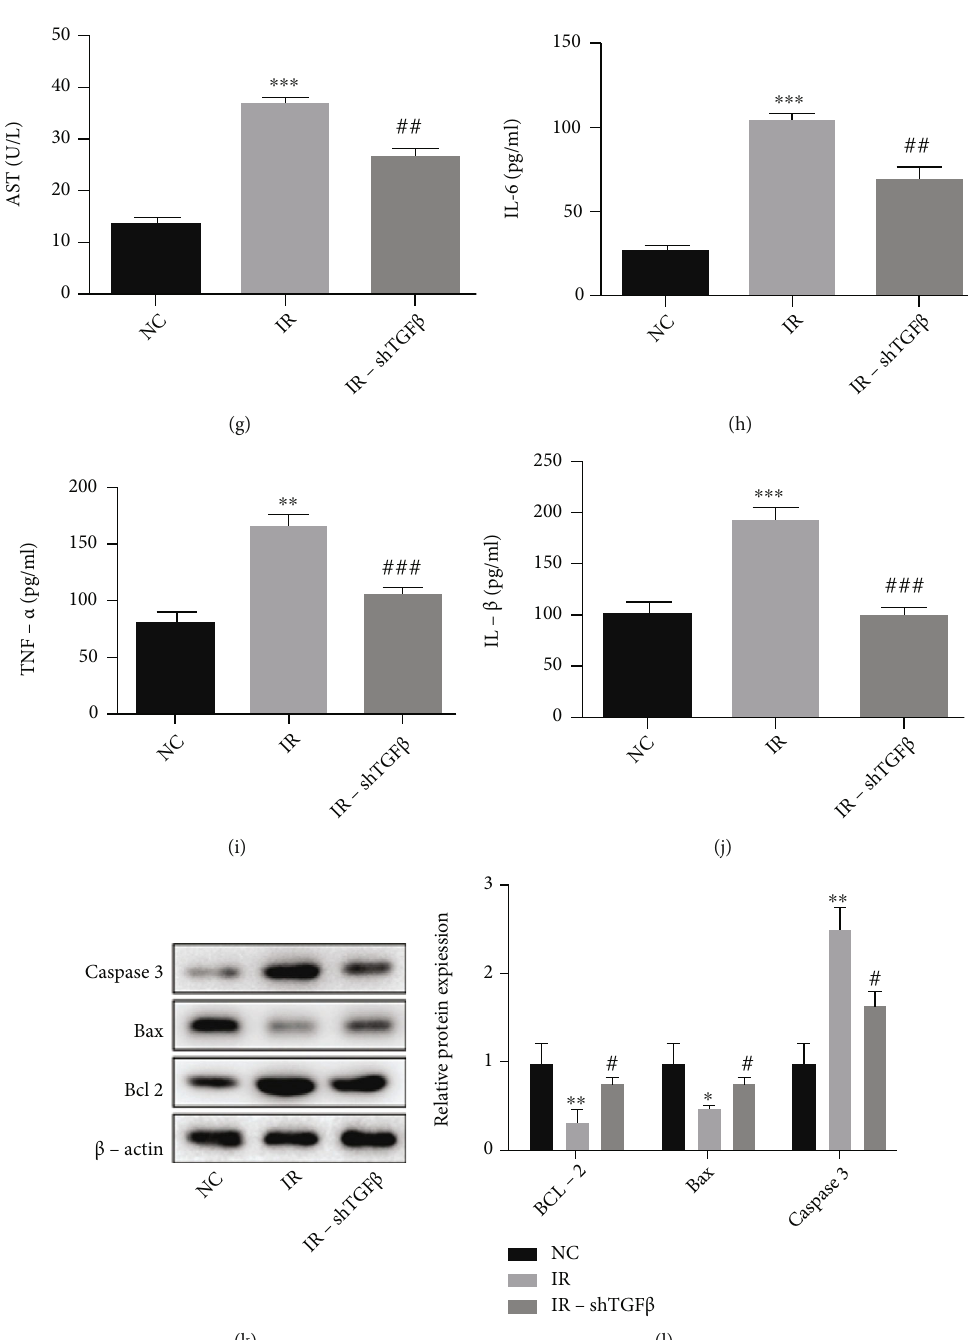
Figure 3: Expression of molecules related to TGF- β signaling pathway, antioxidants, in fl ammation-associated cytokines, and apoptosis- related molecules at 24 h after I/R and another 72 h after H9C2 cells were transfected with shRNA-TGF- β . (a and b) Expression of TGF β , p-Smad2/3, Smad4, Smad6, and Smad7 in the cells from the control group and I/R group at 24h after I/R (Western blotting). (c) The thiobarbituric acid method was employed to detect MDA level. (d) The hydroxylamine method was used to detect SOD. (e – g) Serum levels of CK, LDH, and AST were detected with corresponding ELISA kits. (h – j) In fl ammation-related factors (IL-1 β , TNF- α , and IL-6) were detected with corresponding ELISA kits. (k and l) Expression of BCL-2, Bax, and caspase-3 (Western blotting). Data are presented as mean ± SD . ∗ P < 0 : 05 , ∗∗ P < 0 : 01 , and ∗∗∗ P < 0 : 001 , IR group vs. NC group. # P < 0 : 05 , ## P < 0 : 01 , and ### P < 0 : 001 , IR-sh TGF- β group vs. IR